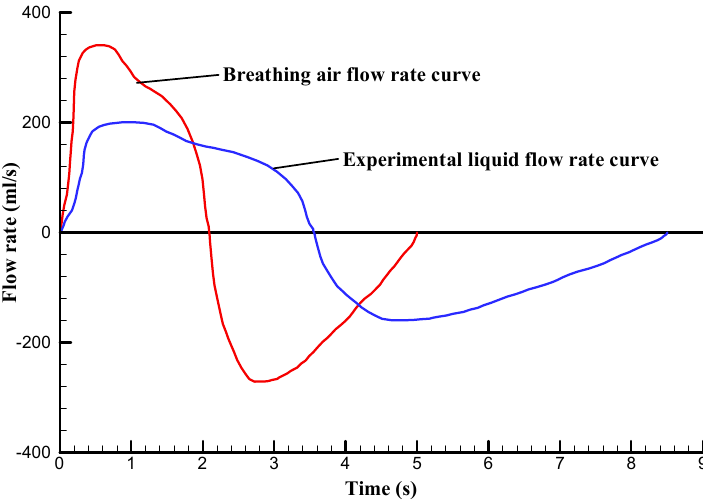
Figure 4. Human breathing and modelling flow rate transients.